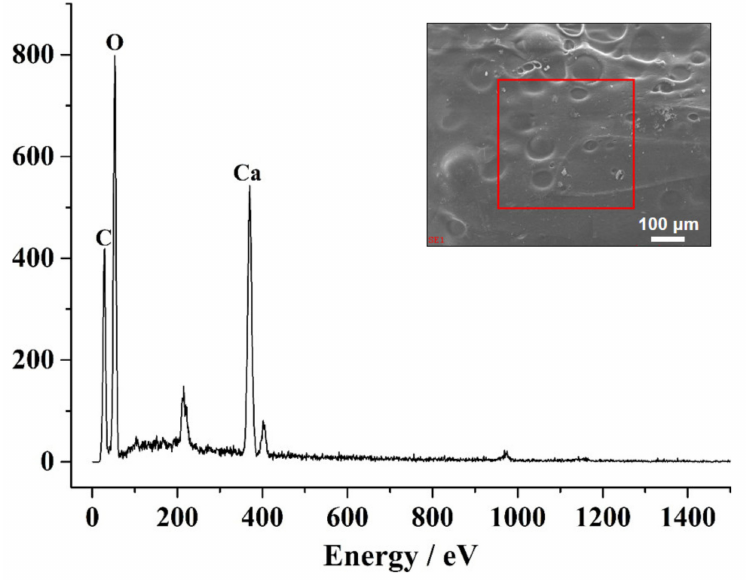
Figure 3. EDS energy spectrum of the partial surface of CA–SC. The inserted image is the selected surface of